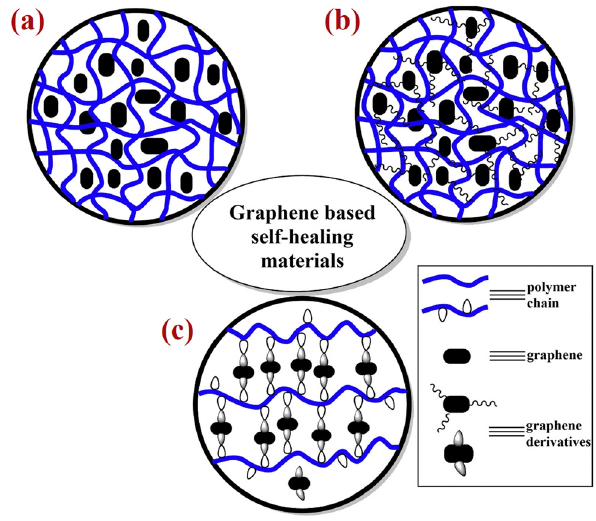
Figure 10: Forms of graphene in self - healing materials: ( a ) gra - phene, ( b ) graphene derivatives, and ( c ) crosslinked polymer/gra - phene [ 100 ]